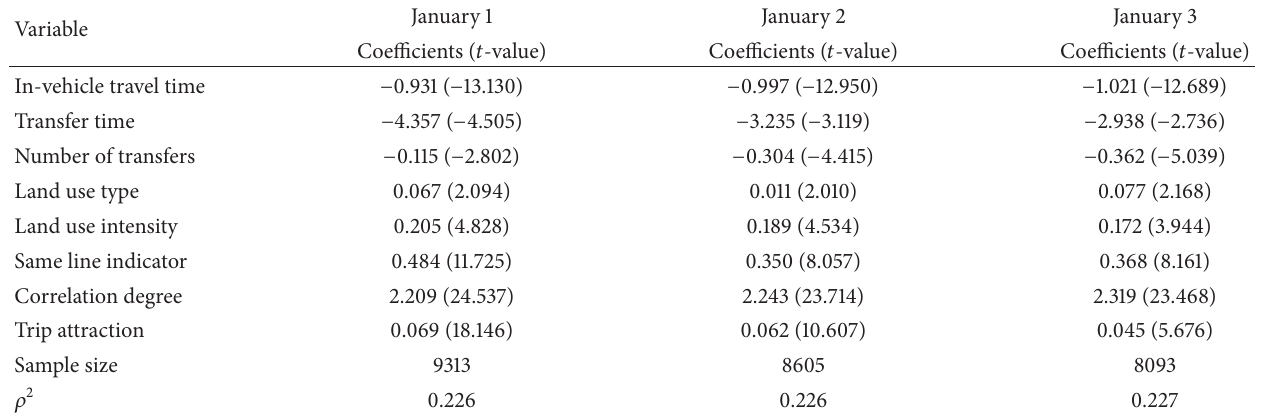
Table 4: Estimation results of holiday destination choice models.